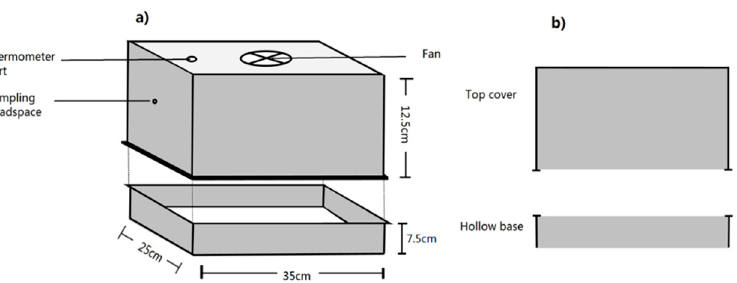
Figure 2. Schematic diagram showing the chamber design. Illustration ( a ) shows a three-dimensional hollow base and a top with a top while illustration ( b ) shows a transverse section of the base and the top cover.